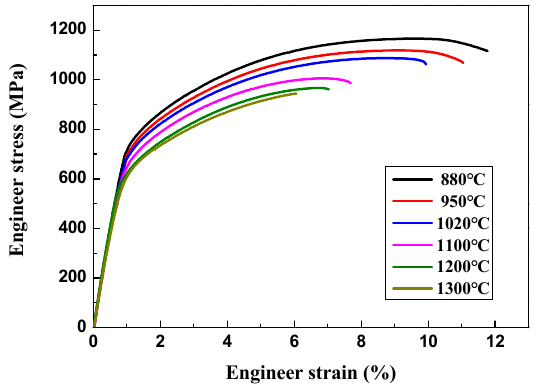
Figure 4. Engineer stress–strain curves of different austenitizing temperatures.